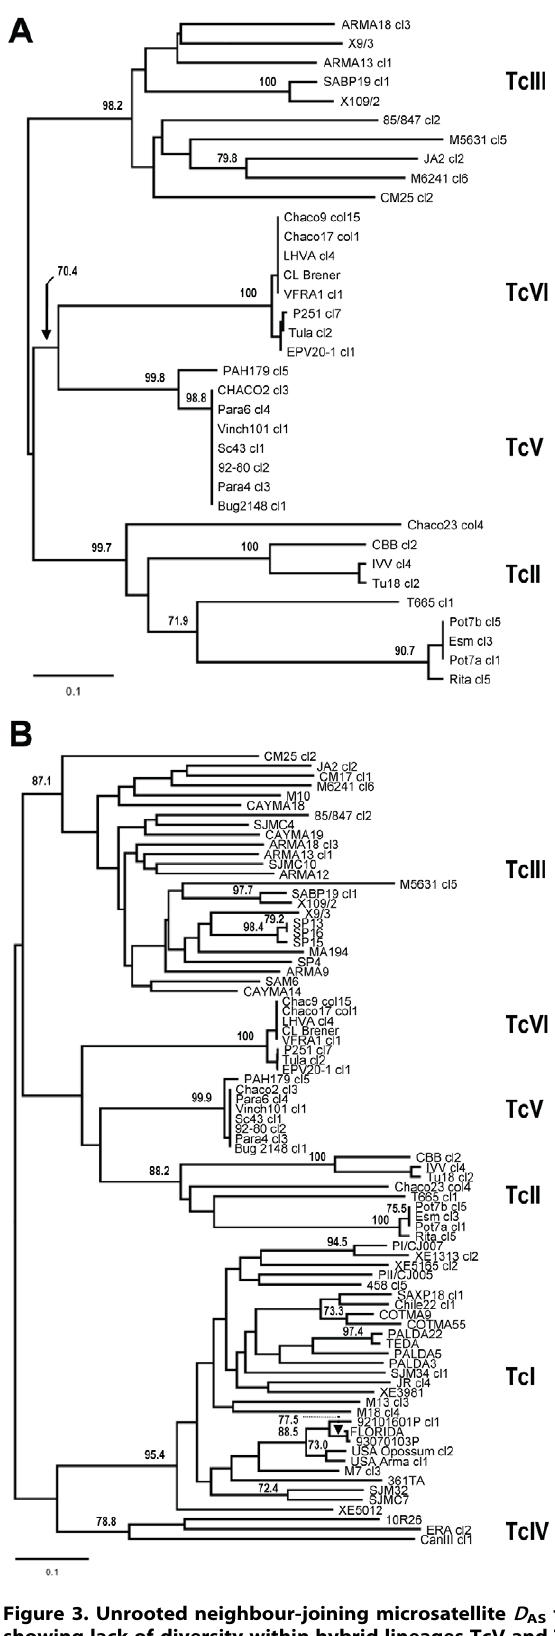
Figure 3. Unrooted neighbour-joining microsatellite D AS trees showing lack of diversity within hybrid lineages TcV and TcVI. A) Tree based on 28 loci typed across 35 samples from parental (TcII, TcIII) and hybrid (TcV, TcVI) lineages. B) Tree based on 19 loci